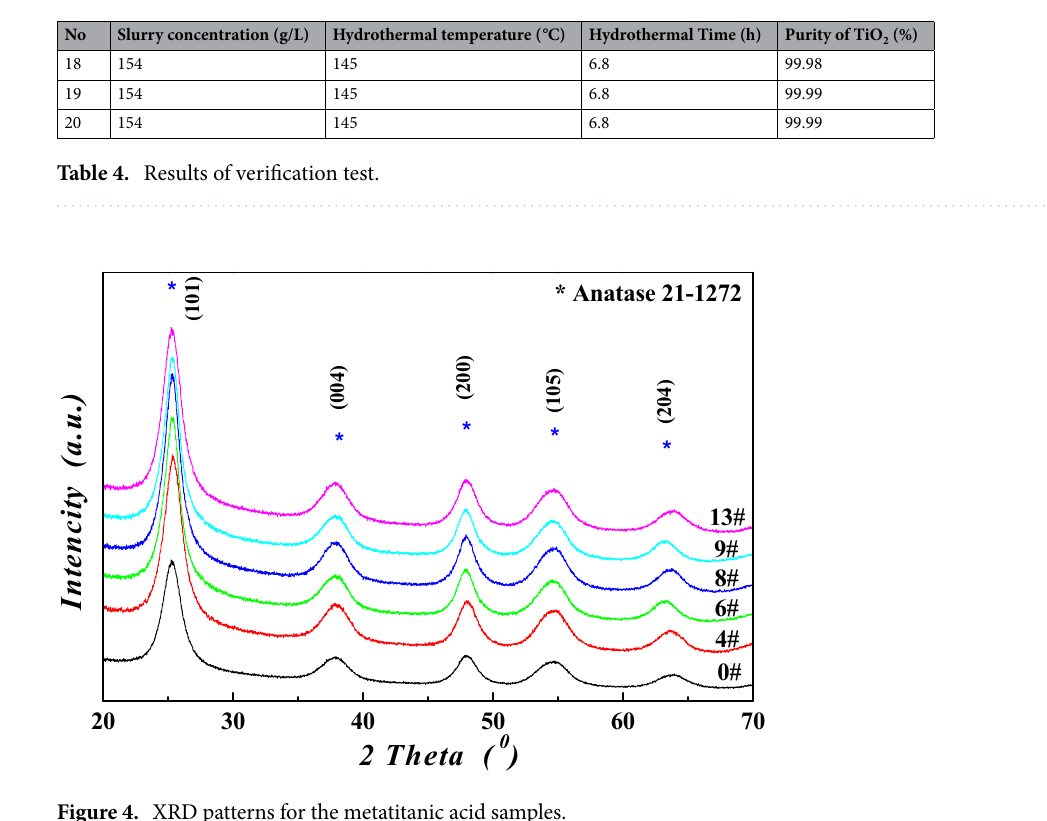
Figure 4. XRD patterns for the metatitanic acid